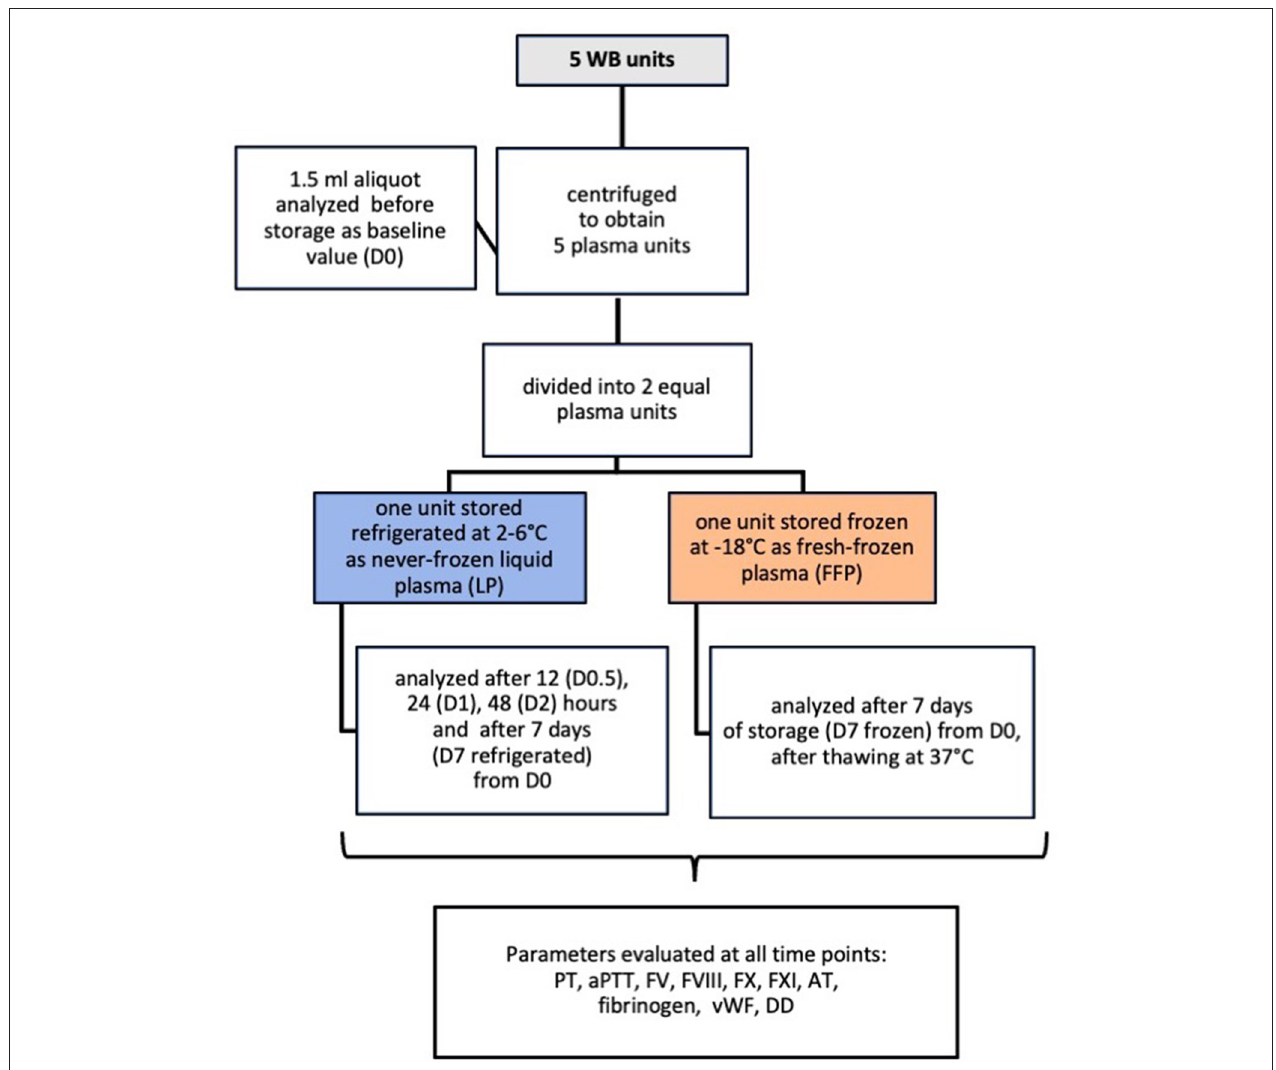
FIGURE 1 | Flowchart summary of the study design in which 5 canine never-frozen liquid plasma units were evaluated for changes in hemostatic activity when stored refrigerated for 7 days compared to frozen